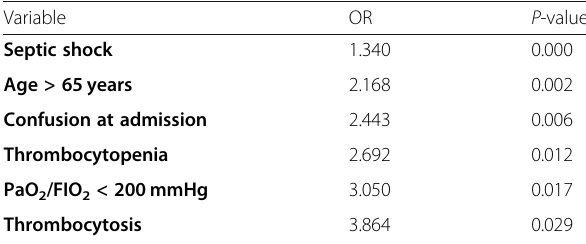
Table 9 Predictors of 30 days mortality among hospitalized patients with CAP in this